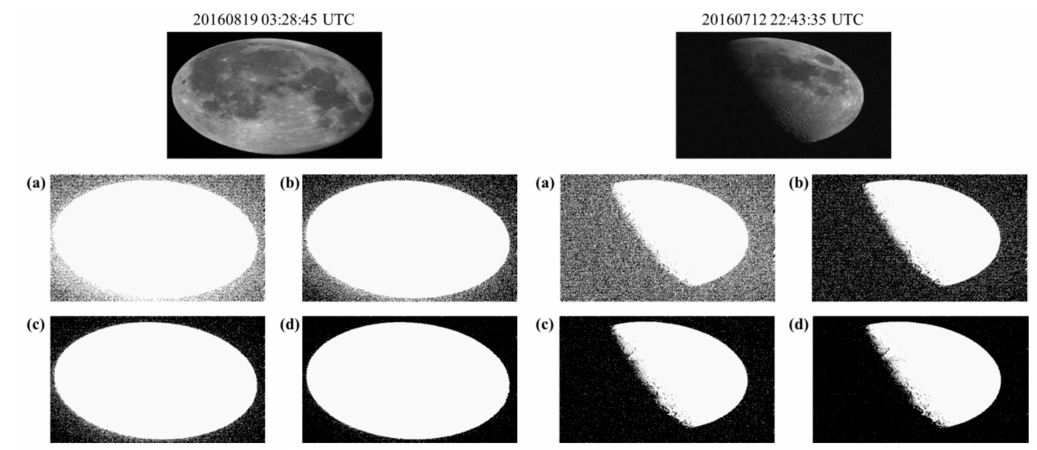
Figure A1. Differences in Moon pixels due to the threshold value on selected Moon area (560 × 330). (Top) Moon observation image and associated threshold values of: (a) 800, (b) 820, (c) 840, and (d) 860.